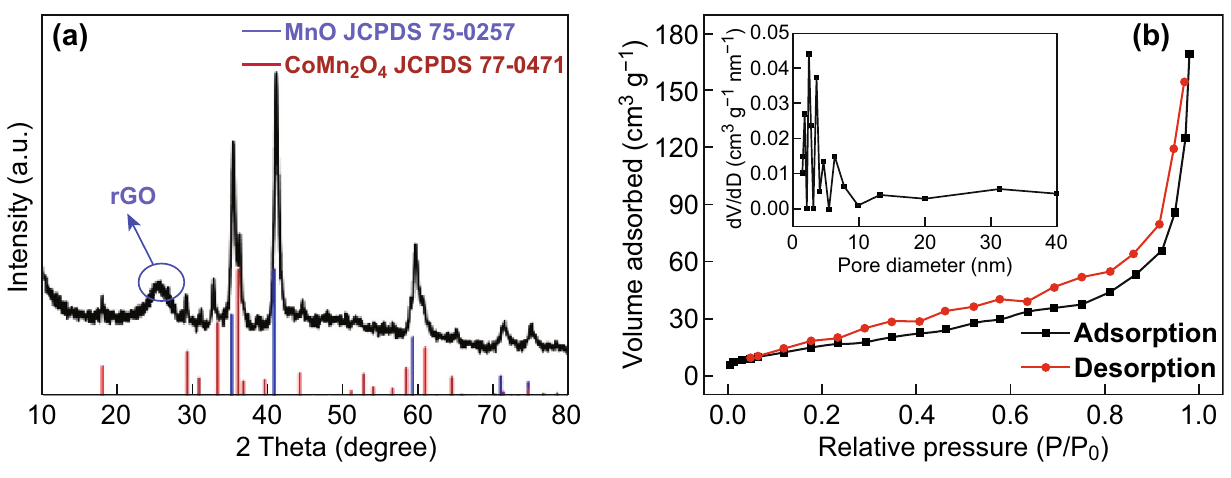
Fig. 3 a XRD pattern of the MnO/CoMn 2 O 4 ⊂ GN, b Nitrogen adsorption–desorption isotherms and corresponding pore size distribution plot of the MnO/CoMn 2 O 4 ⊂